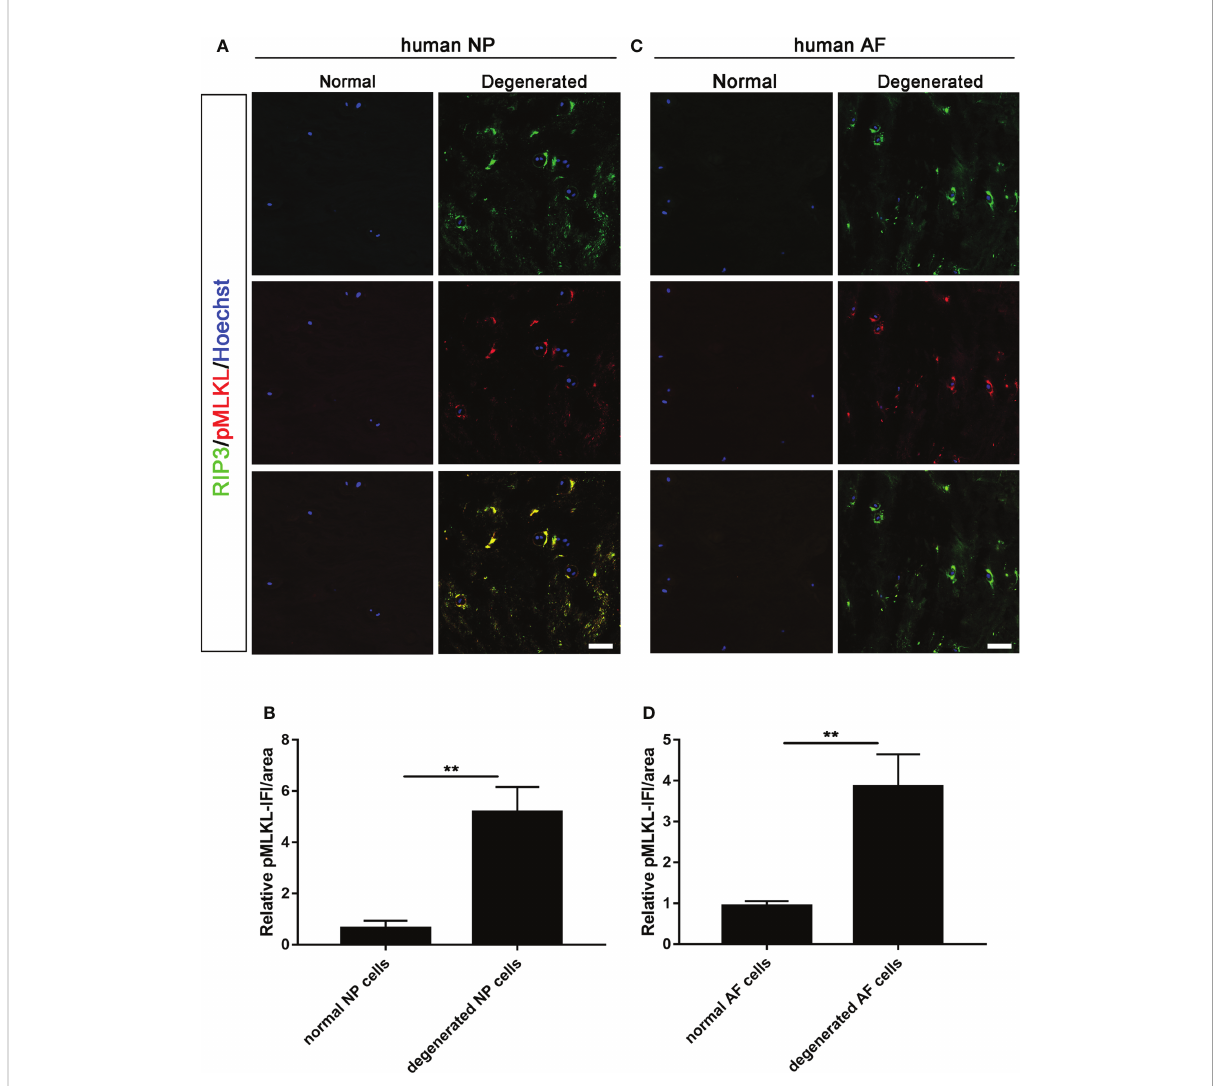
FIGURE 2 Analysis of necroptosis of NP cells and AF cells in the normal and degenerated disc. (A) Double-staining of RIP3 with p-MLKL was performed to detect necroptotic NP cells in normal and degenerated disc. (B) Relative IF intensity of p-MLKL in NP cells. (C) Double-staining of RIP3 with p-MLKL was performed to detect necroptotic AF cells in disc. (D) Relative IF intensity of p-MLKL in AF cells. **P < 0.01. N = 6. Bars = 50 m